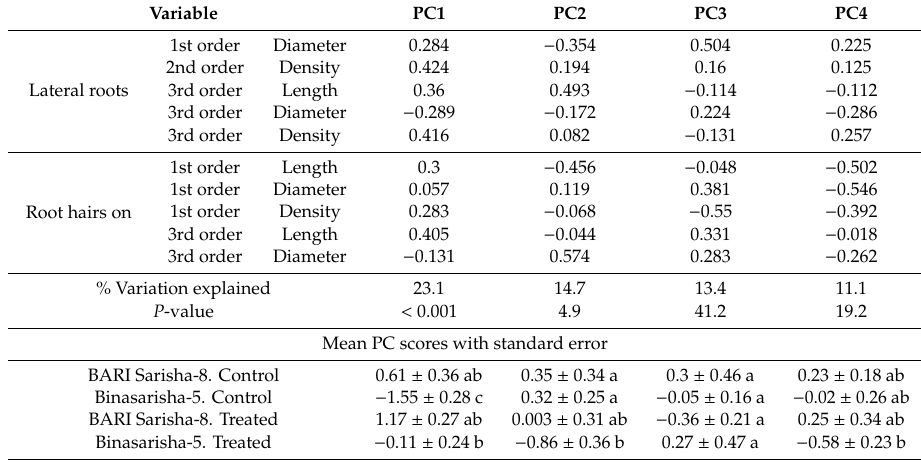
Table 3. Coe ffi cients of principal components (PCs) and mean PC scores of each genotype × treatment combination. Di ff erent letters indicate significant di ff erences among the genotype × treatment interactions after Tukey’s pairwise